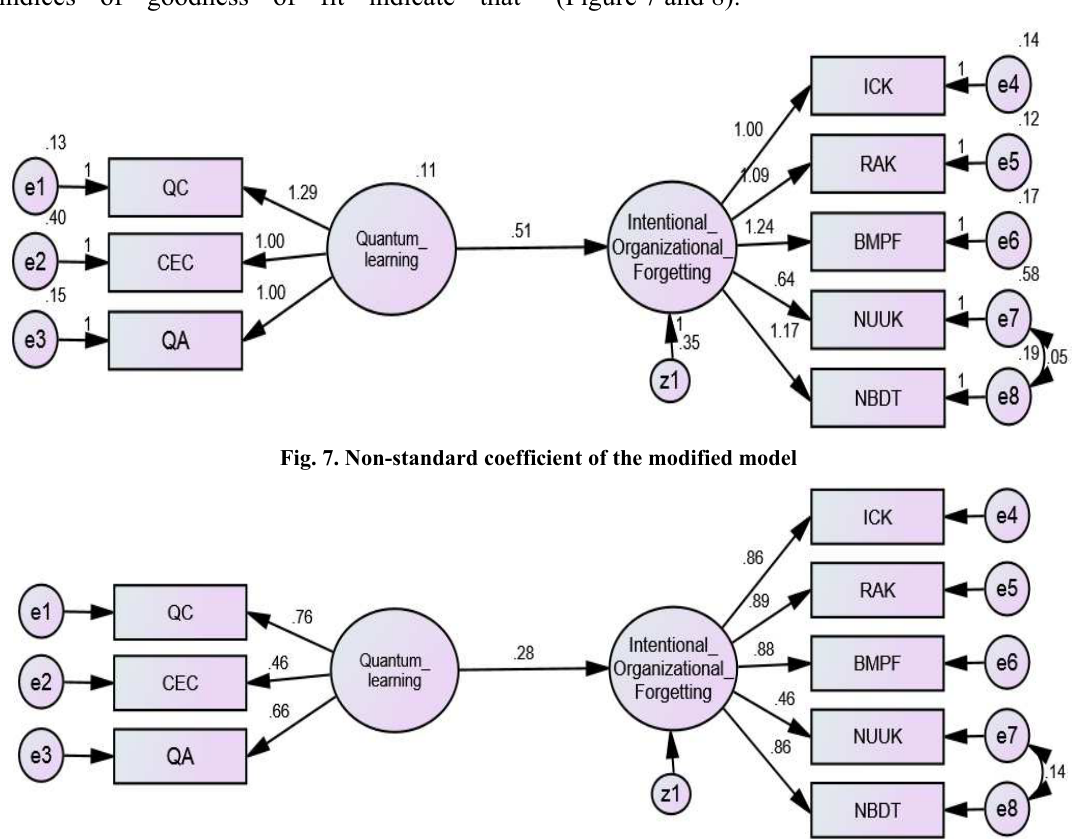
Fig. 7. Non-standard coefficient of the modified model